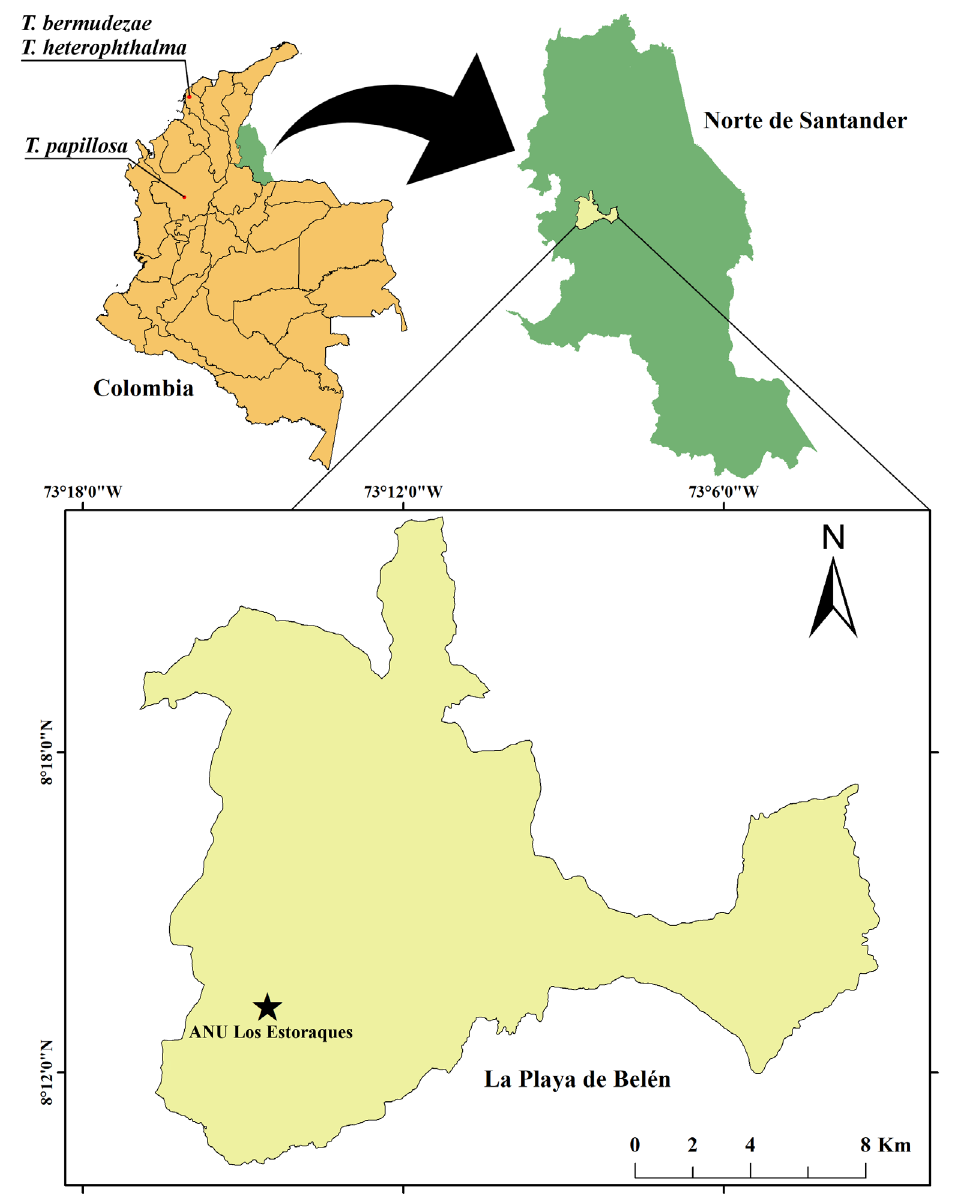
Figure 4. Map of the study area and location of the ANU Los Estoraques, La Playa de Belén, Department of Norte de Santander, Colombia